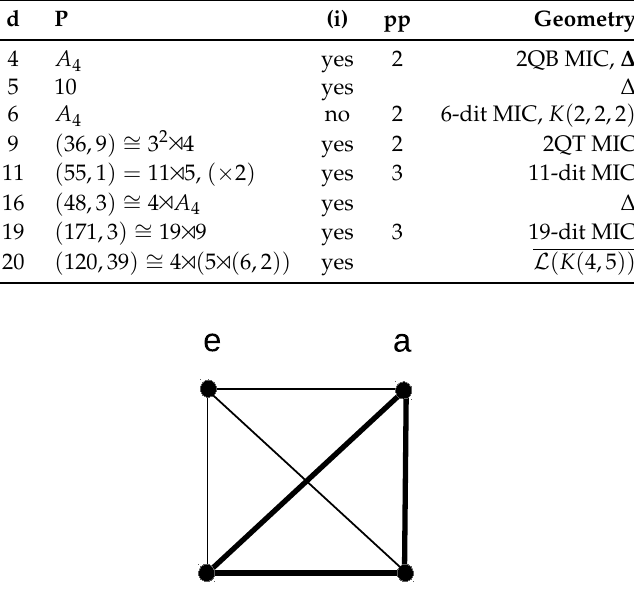
K 4 a 1 ( 0,1 )] with K 4 a 1 ( 0,1 ) , the 0-surgery Table 1. Table of subgroups of the fundamental group π 1 [ S 3 \ over the figure-eight knot. The permutation group P organizing the cosets in column 2. If (i) is true, unless otherwise specified, the graph of cosets leading to a MIC is that of the d -simplex and/or the condition (ii) is true: no geometry. The symbol ∆ means that (ii) fails to be satisfied. When there exists a